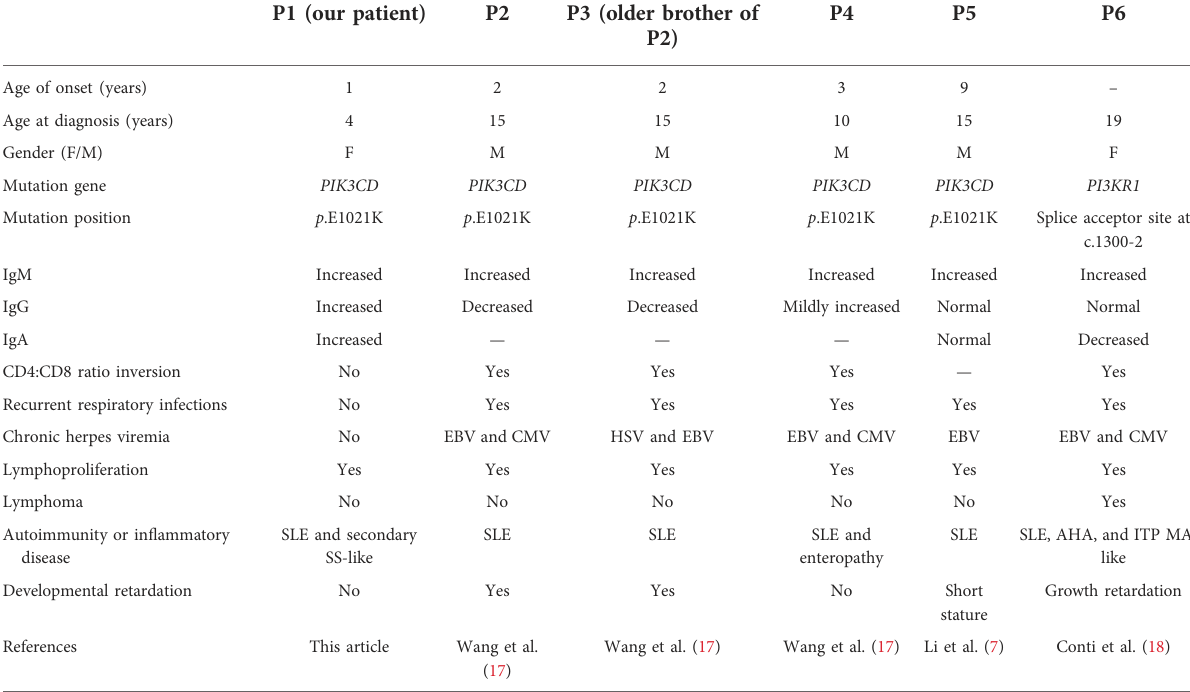
TABLE 1 Clinical features of APDS patients with SLE